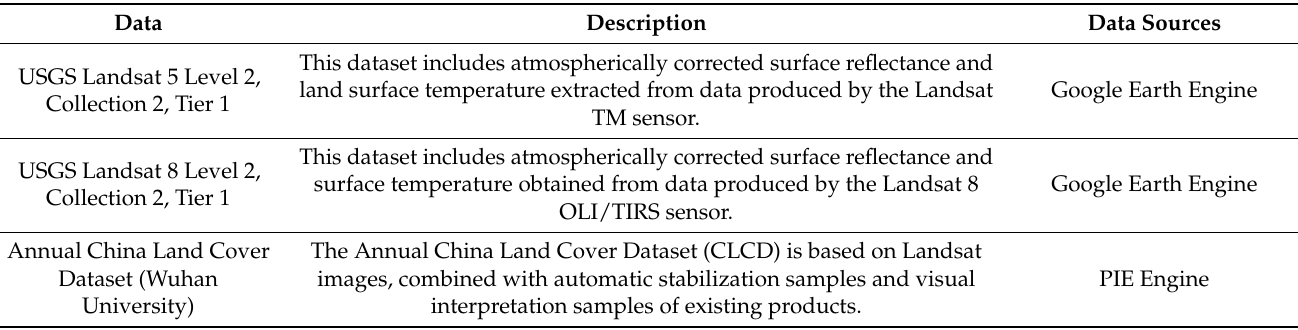
Table 1. List of data used in the